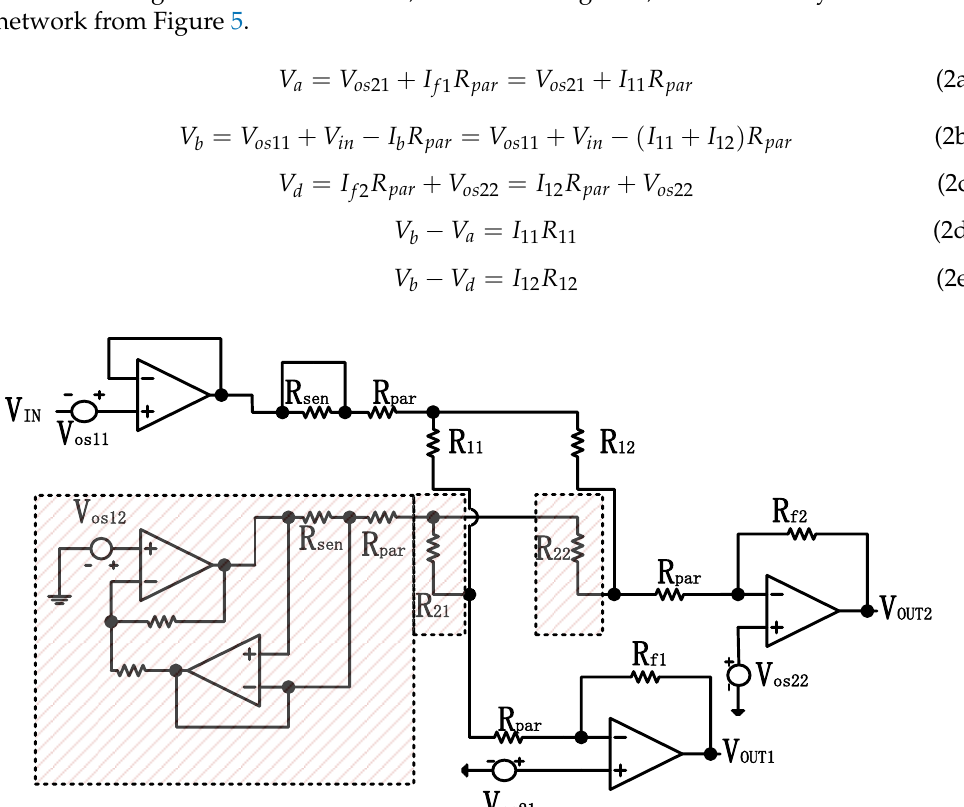
Figure 5. A 2 × 2 array circuit model including parasitic effects and crosstalk current effect for DZCM.